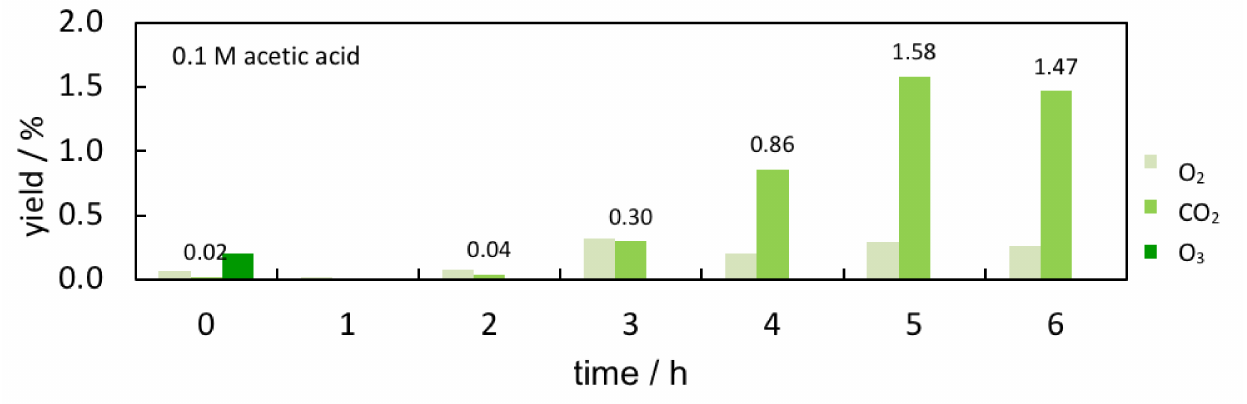
Figure 5. Yield of collagen extracted from tilapia scales using 0.1 M acetic acid and different gases. Yields were calculated using Equations (1) and (2) based on the concentration values obtained from circular dichroism (CD) values at 221